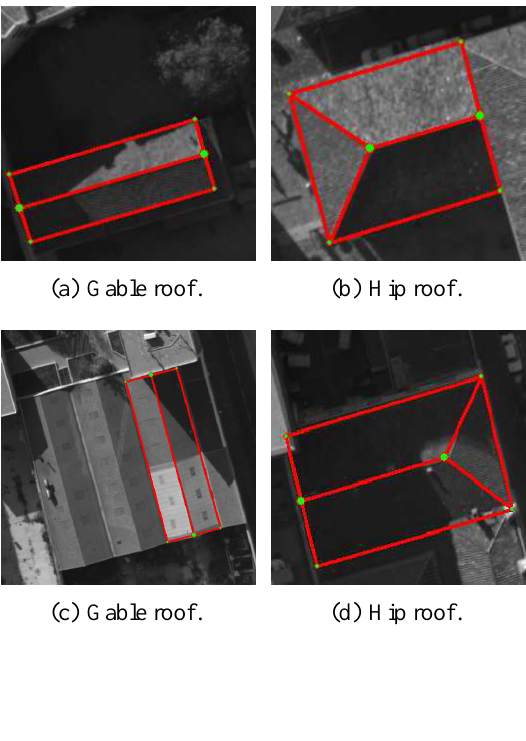
Figure 22. Correct building modeling in the presence of significant shadows. The master images are not